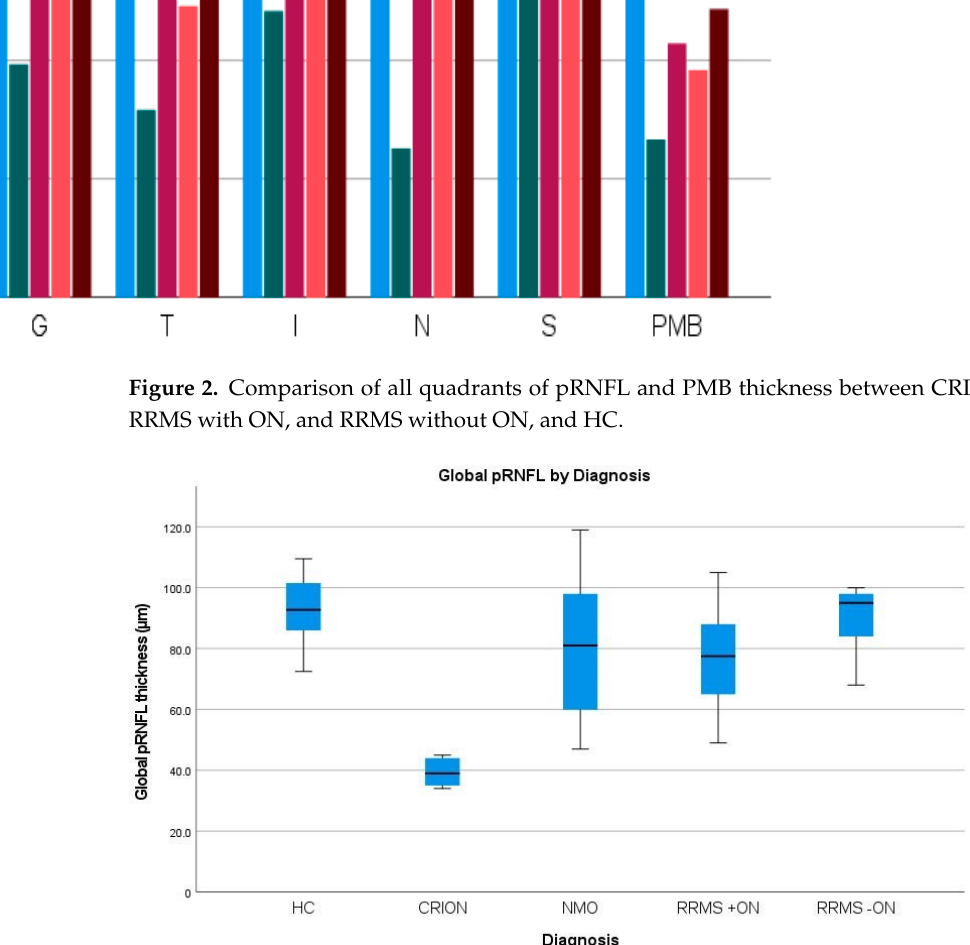
Figure 3. Comparison of global pRNFL in CRION, NMOSD, RRMS with ON (RRMS+ON), RRMS without ON (RRMS-ON), and healthy controls